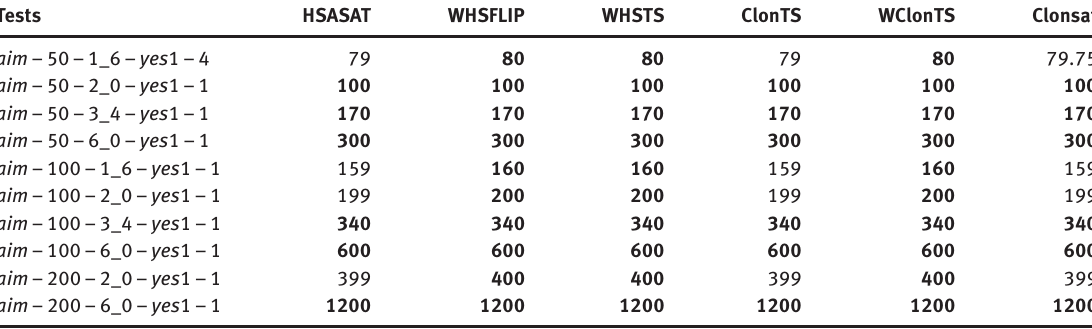
Table 3: Comparative Results 2.